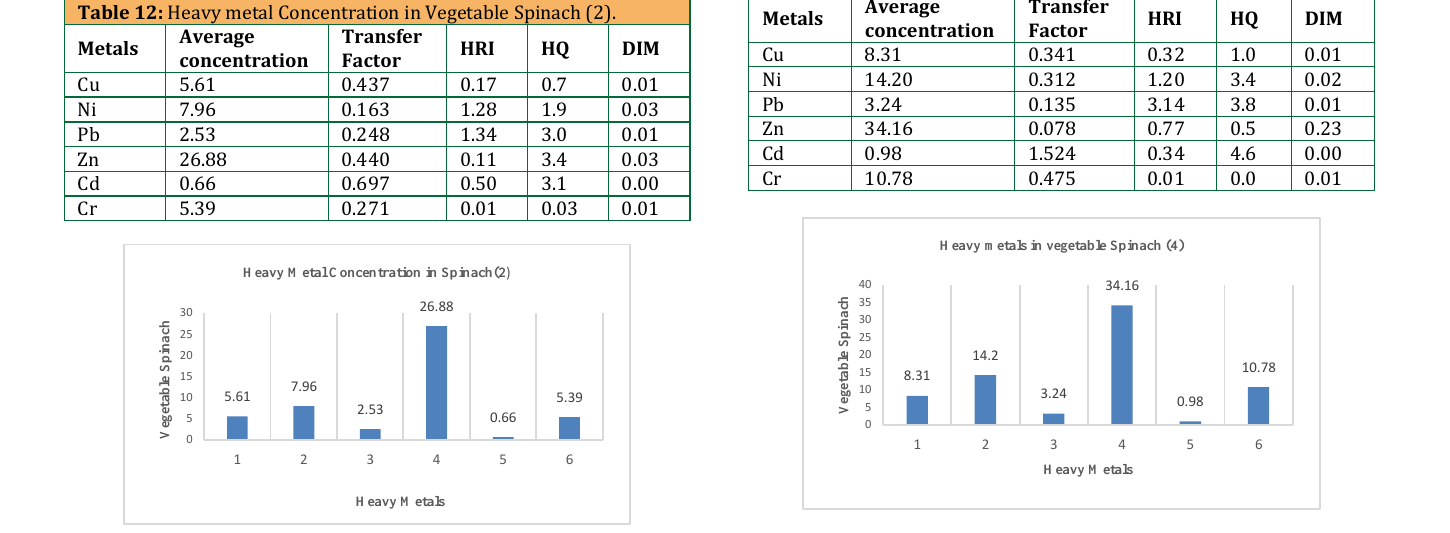
Figure 9: Average Concentration in vegetable Spinach (2)